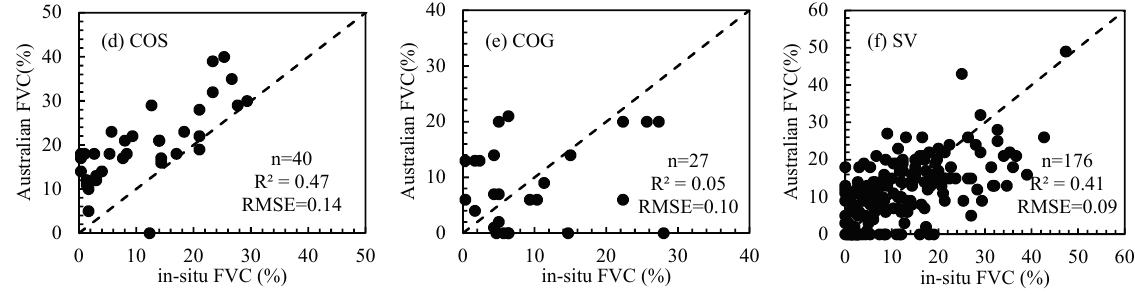
Figure 7. Scatterplots of the Australian MODIS FVC product with the in-situ FVC for different biome types.( a ) rainfed croplands (RC), ( b ) closed to open broadleaved evergreen forest (COBEF), ( c ) open broadleaved deciduous forest (OBDF), ( d ) closed to open shrubland (COS), ( e ) closed to open grassland (COG), and ( f ) sparse vegetation